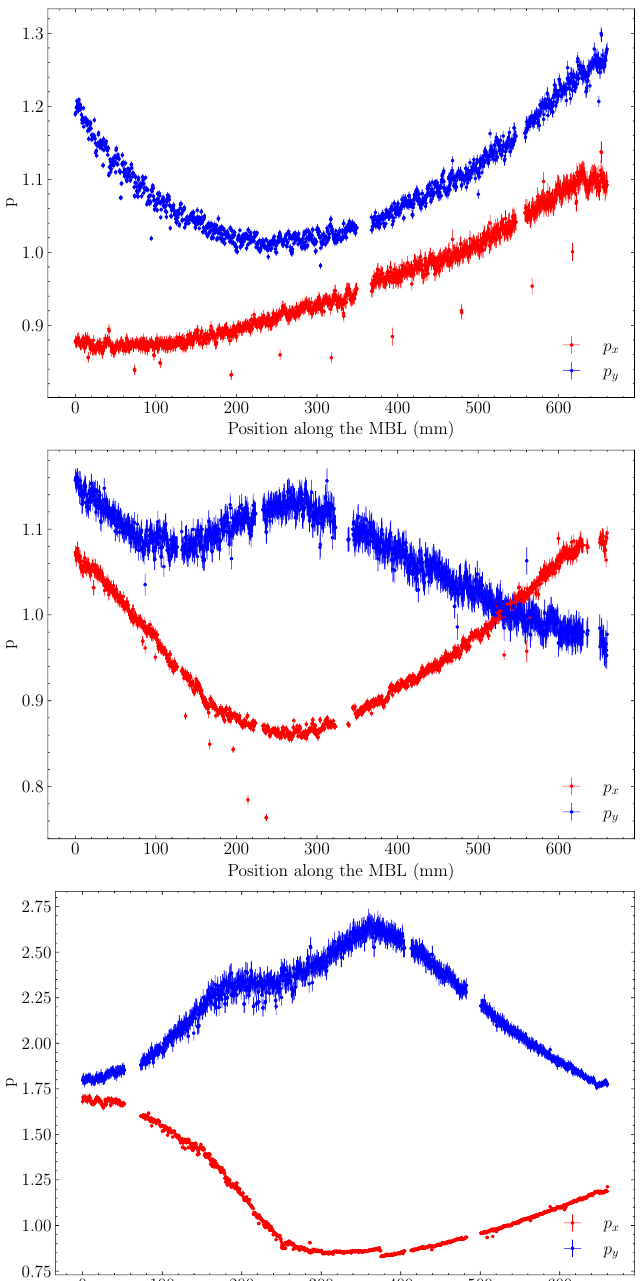
Figure 9. Fitting p x and p y parameters in both horizontal (red) and vertical (blue) planes, along the MBL for the three different cases: MBL magnets off ( top ); a focused beam entering the MBL with magnets on ( center ); a flat beam entering the MBL ( bottom